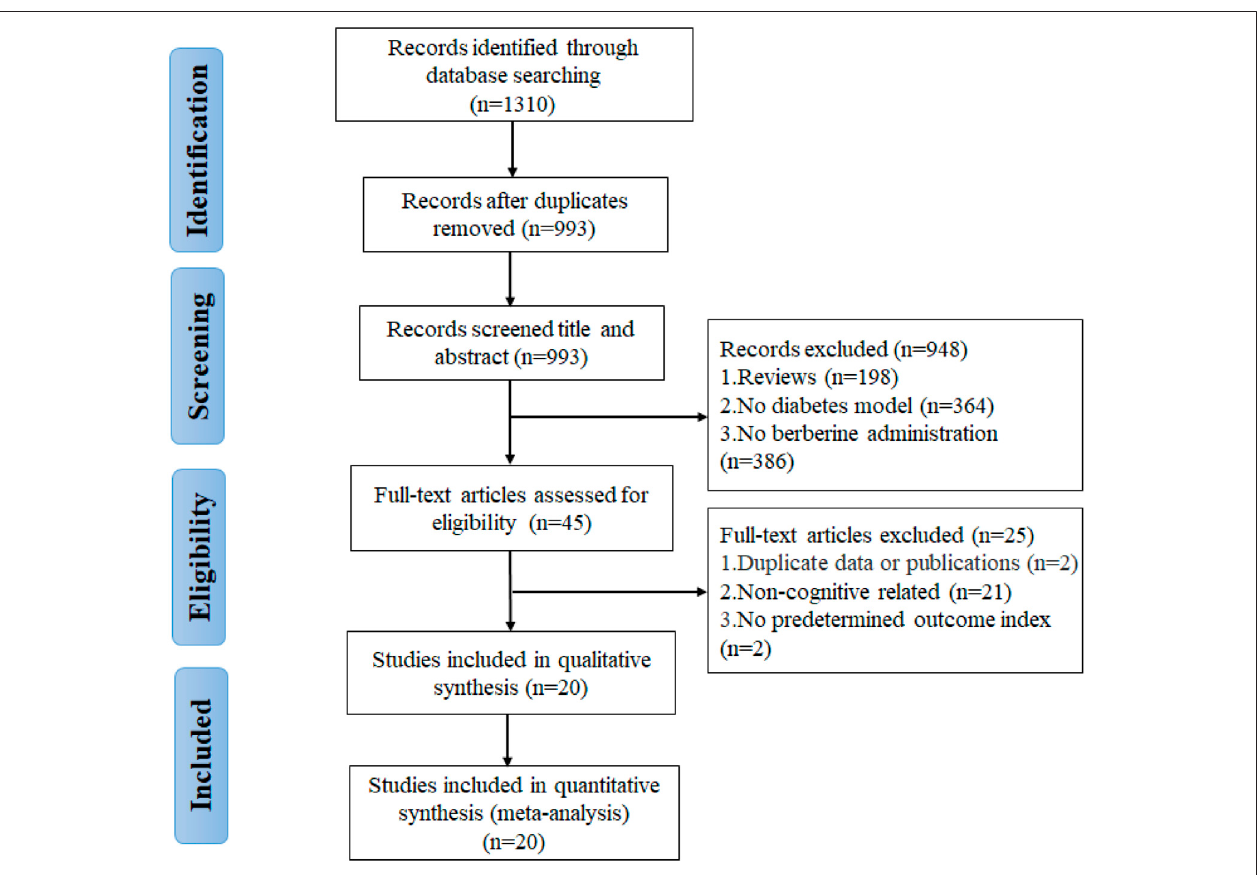
FIGURE 2 | Flowchart of selection for studies